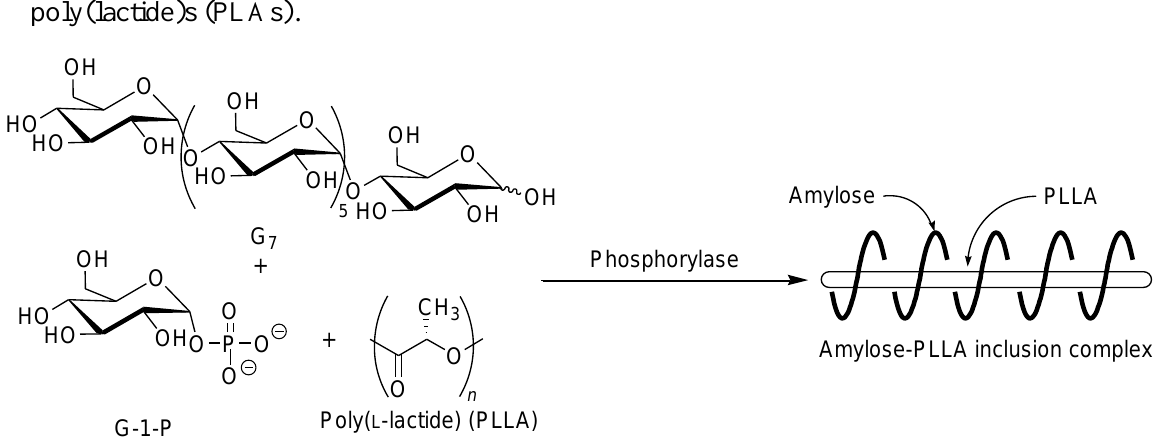
Figure 8. Stereoselective inclusion of amylose by vine-twining polymerization using poly(lactide)s